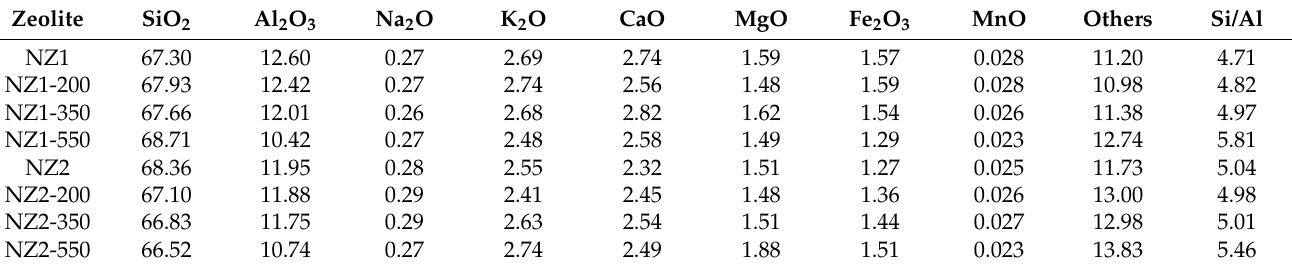
Table 1. Chemical composition (wt.%) of NZ1, NZ2 and thermally treated NZ